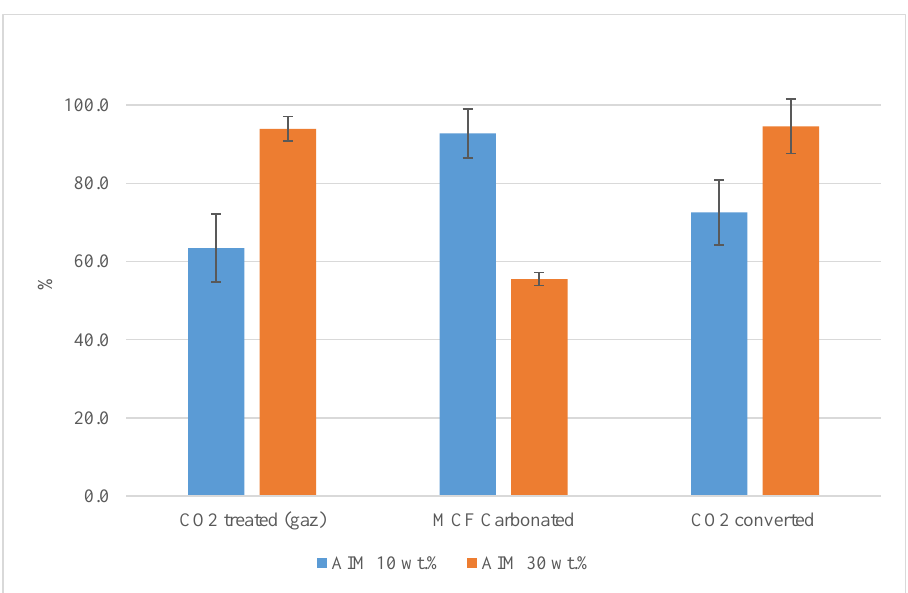
Figure 2. Comparative amount of CO 2 treated, MCF carbonated and the CO 2 converted results between 10 and 30 wt.% L/S ratios (10 min, 10.2 bars).